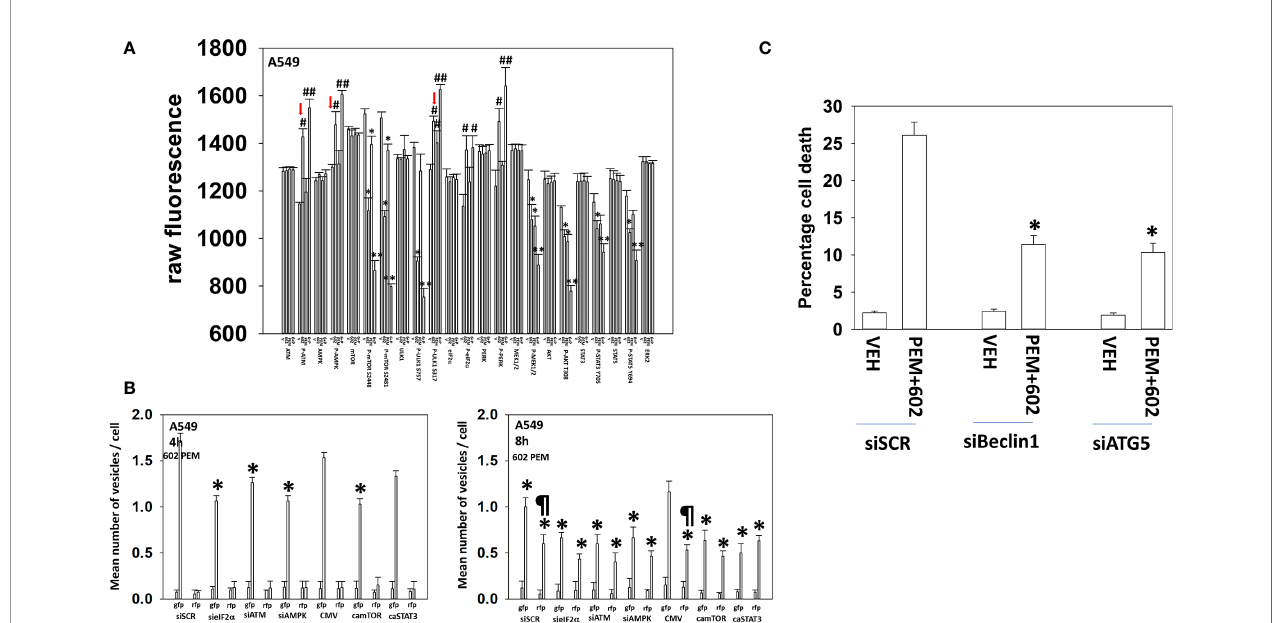
FIGURE 4 | GZ17-6.02 and pemetrexed interact to alter cell signaling, increase autophagosome formation, and kill via toxic autophagy A549 NSCLC cells that express a mutant K-RAS protein. (A) A549 cells were treated with vehicle control, GZ17-6.02 (2 m M fi nal curcumin), pemetrexed (500 nM), or the drugs combined for 6 h. Cells were fi xed in place and immunostaining was performed to determine protein expression and phosphorylation ( n = 3 ± SD) * p < 0.05 less than vehicle; ** p < 0.05 less than GZ17-6.02 alone; # p < 0.05 greater than vehicle control; ## p < 0.05 greater than GZ17-6.02 alone. (B) A549 cells were transfected with siRNA molecules to knock down protein levels or with plasmids to express activated forms of mTOR or STAT3 and then subsequently treated with vehicle or [pemetrexed (500 nM) + GZ17-6.02 (2 m M curcumin fi nal)] in combination for 4 h and 8 h. The number of intense staining GFP+ and RFP+ punctae were determined randomly in at least 50 cells, and the mean number of punctae per cell was determined ( n = 3 ± SD). ¶ p < 0.05 greater than the corresponding values after 4 h; * p < 0.05 less than the corresponding values in siSCR/CMV-transfected cells. (C) A549 cells were transfected to knock down Beclin1 or ATG5 expression. Subsequently cells were treated with vehicle, pemetrexed (500 nM), GZ17-6.02 (2 m M curcumin fi nal), or the drugs in combination for 24 h. Cell viability was determined by trypan blue exclusion ( n = 3 ± SD). * p < 0.05 less than the corresponding values in siSCR